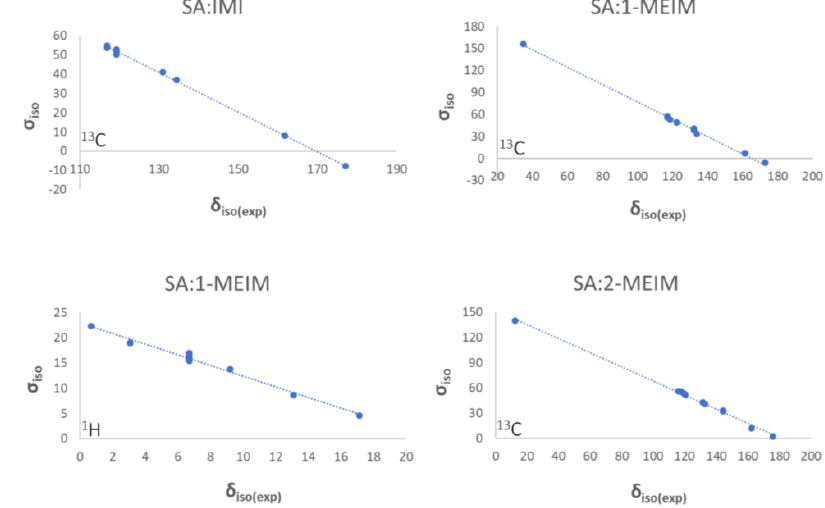
Figure 3. Correlations between theoretical chemical shieldings (σ iso ), obtained from periodic plane- wave density functional theory calculations, against experimental 1 H and 13 C δ iso(exp) of SA:IMI, SA:1-MEIM and SA:2-MEIM.